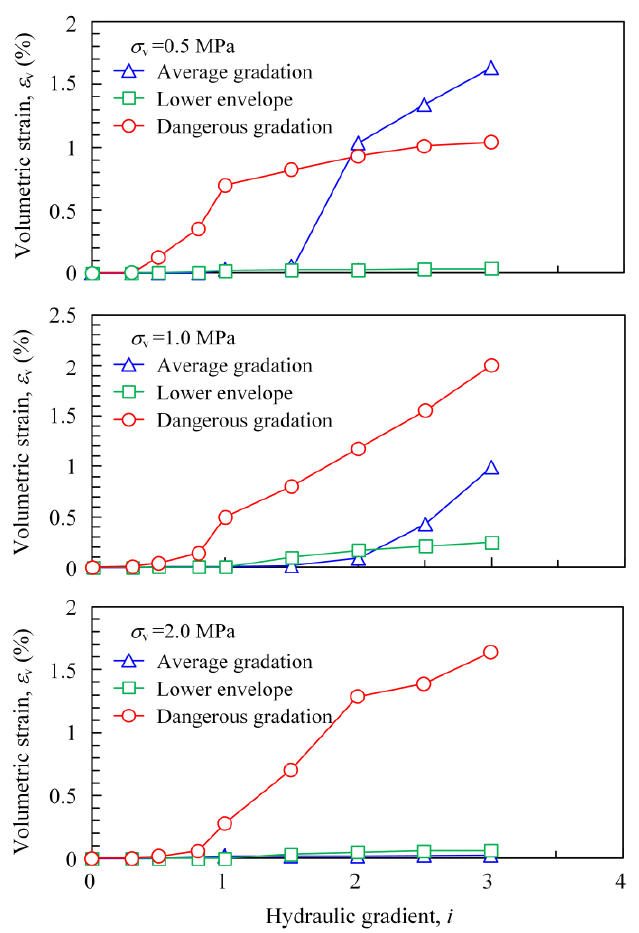
Figure 9. Volumetric strain versus hydraulic gradient.